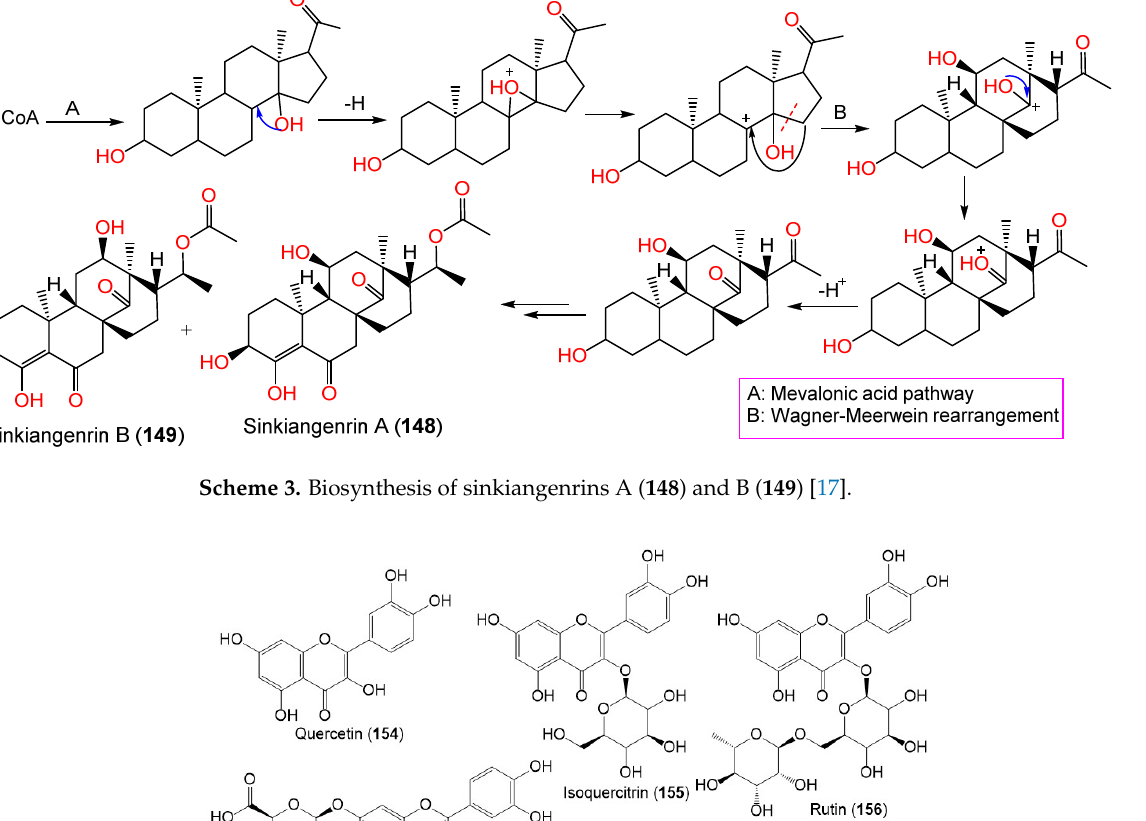
Figure 19. Structures of phenolic compounds ( 170 – 181 ) reported from F. sinkiangensis .